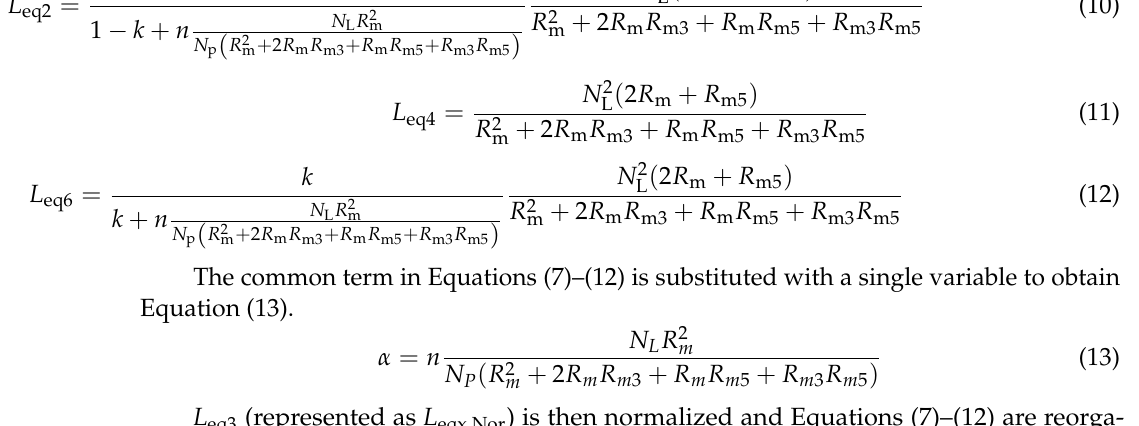
L eq3 (represented as L eqx,Nor ) is then normalized and Equations (7)–(12) are reorga- nized as Equations (14)–(19).